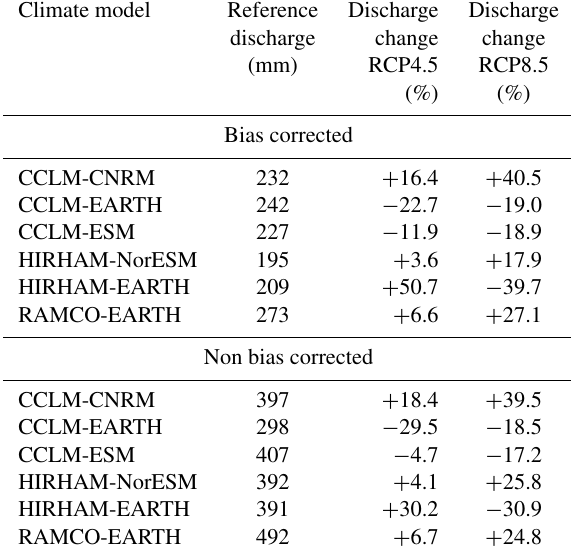
Table 5. Mean annual discharge change projected by the RCM– GCM ensemble for the period 2021–2050 compared to the reference period